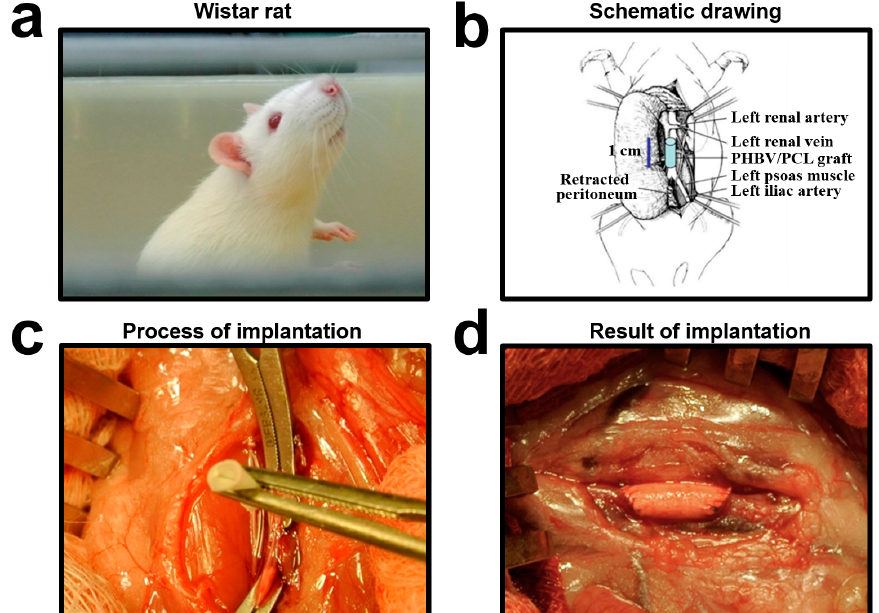
Figure 1. Implantation of the vascular grafts. ( a ) Wistar rat used for implantation; ( b ) schematic drawing of the surgery; ( c ) the process of implantation—aorta is temporarily clamped proximally and distally; ( d ) implanted graft, the anterior abdominal wall before the closure. PCL: poly( ε -caprolactone); PHBV: poly(3-hydroxybutyrate- co -3-hydroxyvalerate).